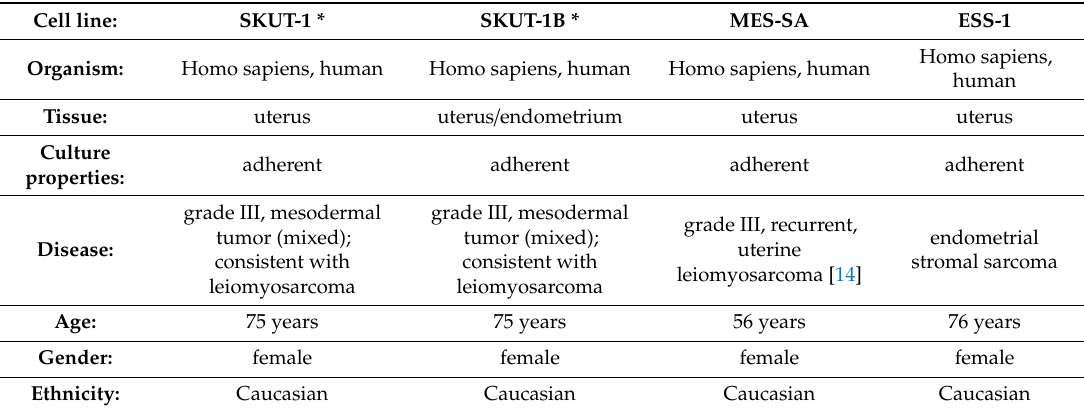
Table 1. The characteristics of used cell lines